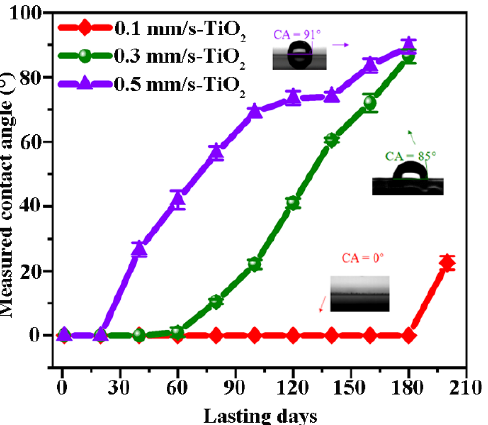
Figure 3. Measured evolution of the superhydrophilic persistence on the surface of Laser-TiO 2 sam- ples with time elapsing.